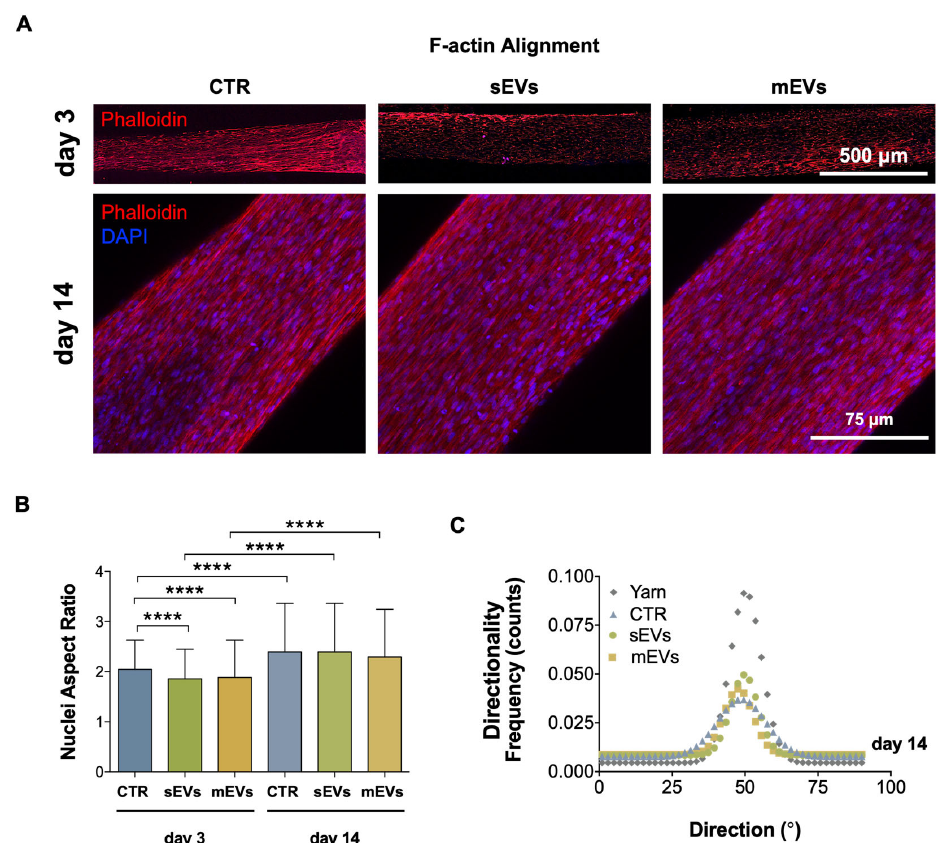
Figure 3. Morphometric analysis of hASCs onto collagen-coated biomimetic yarns either with or without EVs. ( A ) Confocal microscopy images of hASCs encapsulated in collagen-coated yarns after 3 d of culture (phalloidin: red) and 14 d of culture (phalloidin: red; DAPI: blue). Scale bars: 500 μ m and 75 μ m. ( B ) Nuclei aspect ratio of hASCs at 3 and 14 d of culture. Data are presented as mean ± SD. Statistical significance: **** p < 0.0001. ( C ) Directionality analysis of hASCs F ‐ actin filaments after 14 d.